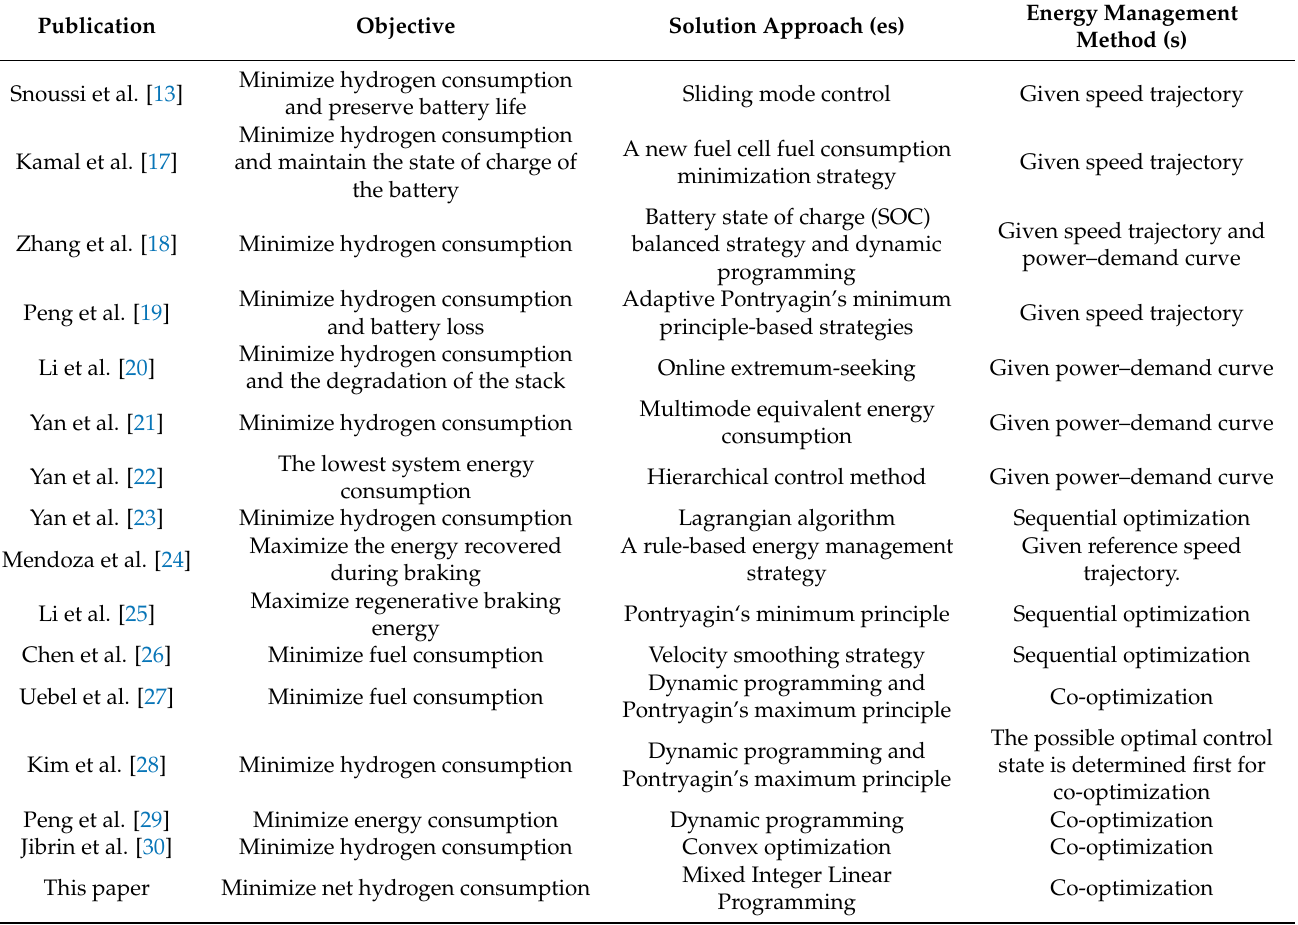
Table 1. Overview of the existing research of FCHT energy